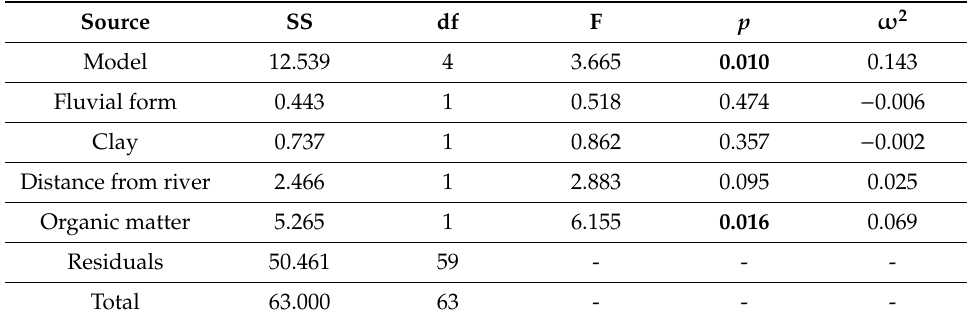
Table 4. Summary of GLM performed with RC1 (SS: Sum of Squares, df: degree of freedom, F: F-statistic, p : significance, ω 2 : e ff ect size; p < 0.05 is highlighted with bold).